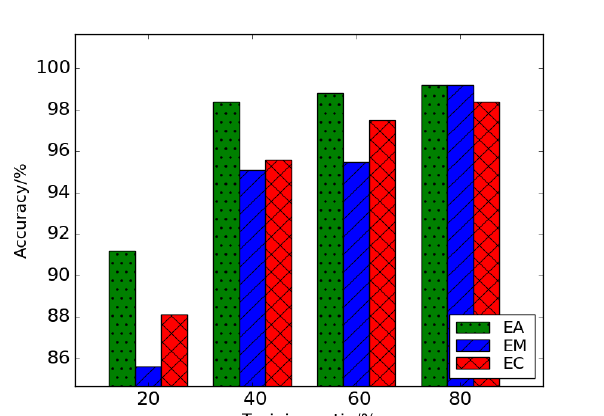
Figure 7. The accuracy performance of various consensual functions, including EA, EM and EC-based MGRALN,